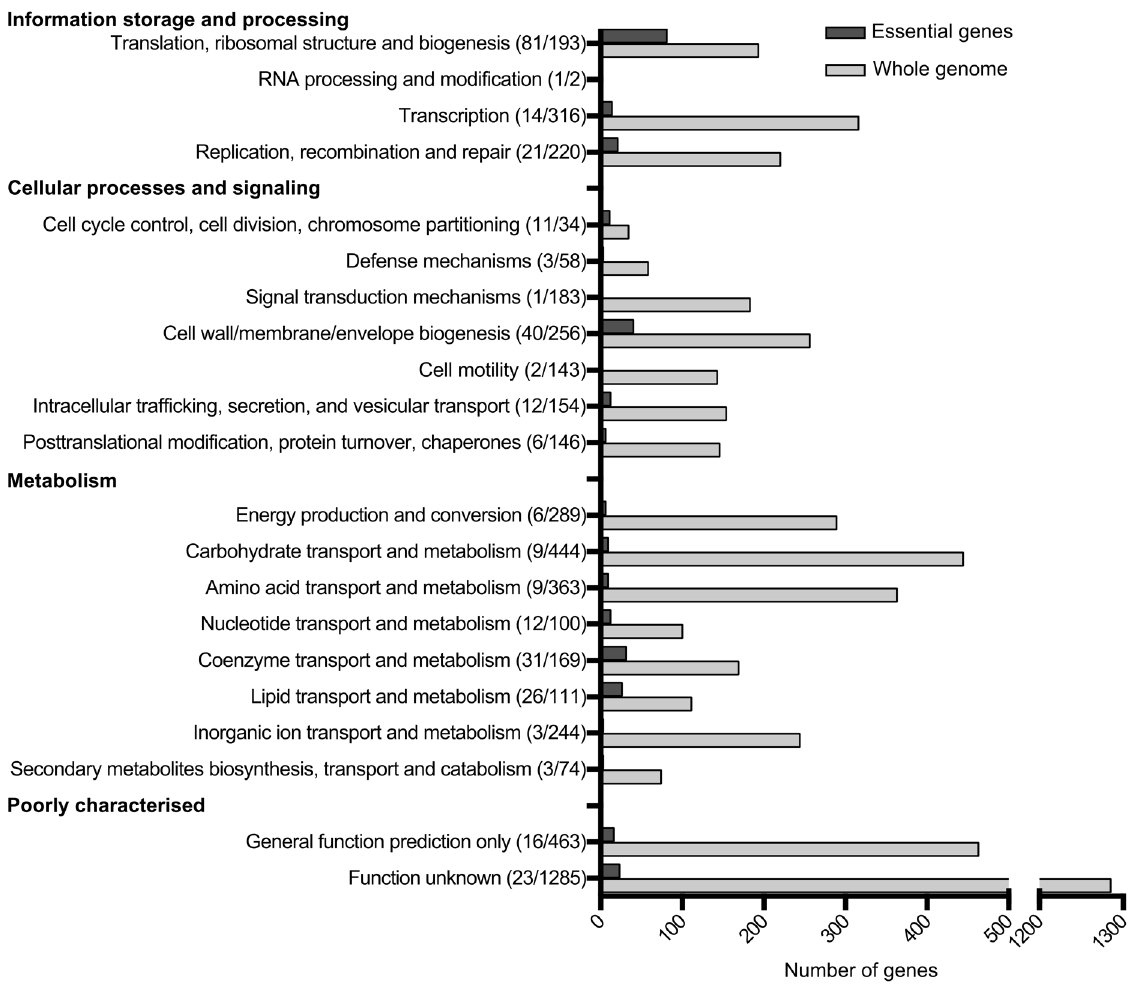
Figure 2. Number of essential genes in each COG functional category.